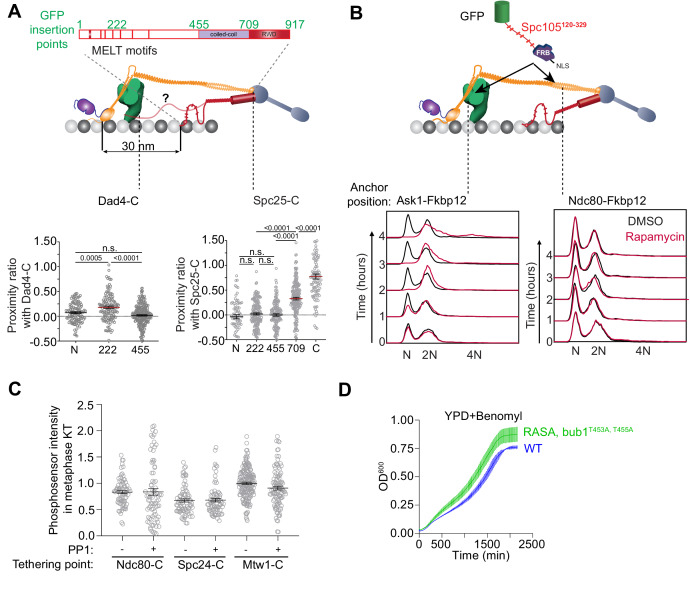
The distribution of the Spc105 phosphodomain in bioriented kinetochores and the position-dependent effects of tethering an additional phosphodomain within the kinetochore.(A) The assessment of the nanoscale distribution of the unstructured phosphodomain of Spc105 using FRET. Top: Schematic displays the GFP-insertion positions within Spc105. Middle: Positions of the mCherry tagged kinetochore subunits (Dad4-C and Spc25-C) that demarcate the region that was expected to be occupied by the Spc105 phosphodomain. Bottom: Scatter plots show the proximity ratio (which is proportional to FRET) of donor GFP fused at the indicated residue in Spc105 with Spc25 C-terminus (left) and Dad4 C-terminus (right). (mean+ s.e.m. n = 74, 165, 142, 177 and 103 respectively for FRET involving Spc25-mCherry, accumulated from at least three repeats. n = 114, 134 and 224 for N, 222 and 455 respectively from three repeats for FRET involving Dad4-mCherry, accumulated from at least two repeats). n.s. Not significant. (B) Flow cytometry-based quantification of the DNA content in cells treated with rapamycin (prior to sample collection at 0 min) to tether the Spc105 phosphodomain anchored to Ask1-2xFkpb12 (which is proximal to the CH-domains) or Ndc80-2xFkbp12 (which is distal from the CH-domains) (schematic shown at the top). Bottom: Representative histogram from two trials for each strain is shown. (C) Quantification of amount of Spc105 phosphodomain tethered to bioriented kinetochore clusters (mean+ s.e.m. n = 74 and 80 for Ndc80-C, 78 and 76 for Spc24-C, 102 and 173 for Mtw1-C, pooled from at least two experimental replicates). (D) (Supports in Figure 4C) Quantification of population growth for the indicated strains in benomyl-containing media (30 µg/ml) (mean ± s.e.m., n = at least 3).Figure 3—figure supplement 1—source data 1.Data required to prepare the plots included in Figure 3—figure supplement 1A bottom left and right, C and D.Individual pages were created in this file for each subfigure.